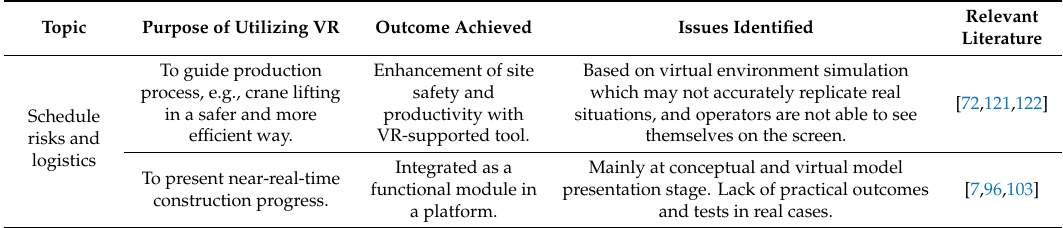
Table 11. Research topics, purpose of virtual reality (VR) adoption, and outcomes achieved in previous